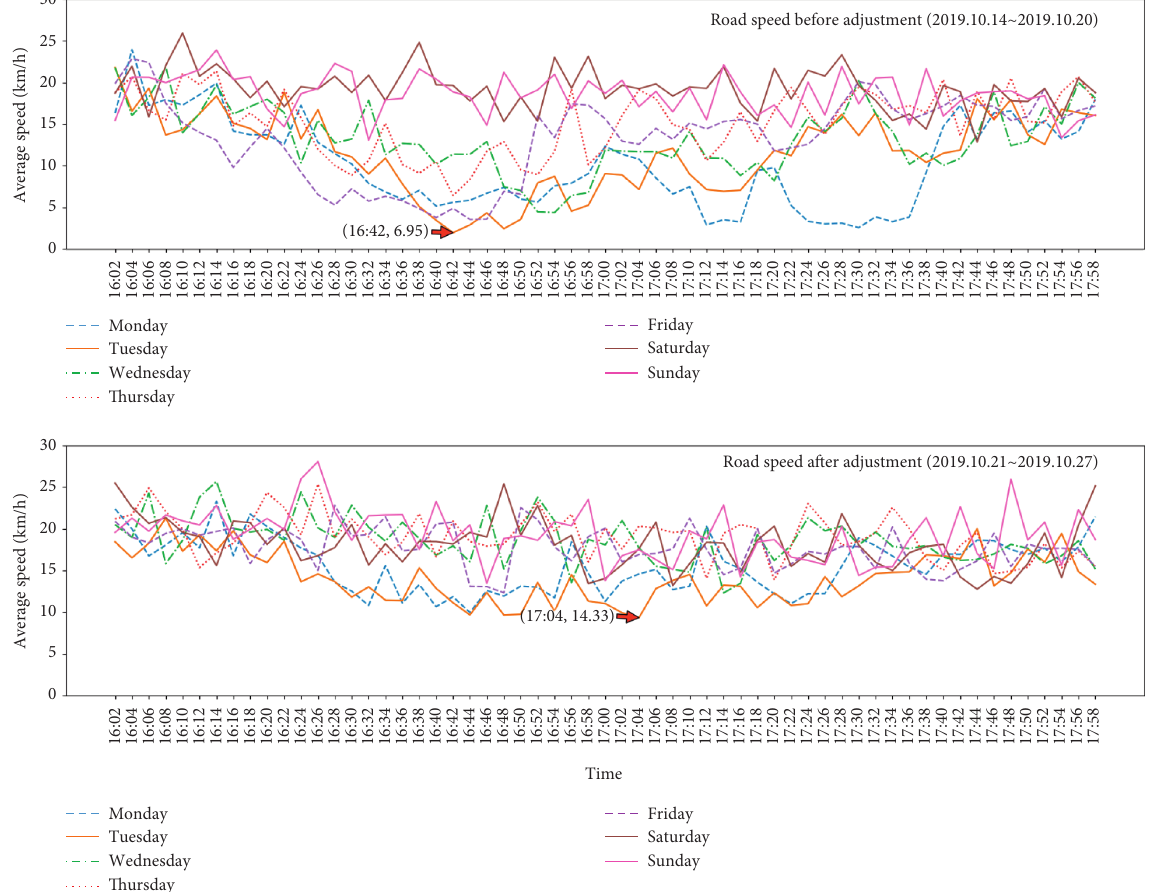
Figure 15: Road speed before and after adjustment in link